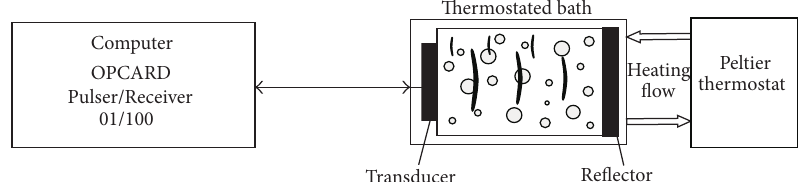
Figure 4: A block diagram of the experimental set-up for ultrasonic monitoring of emulsion stability.